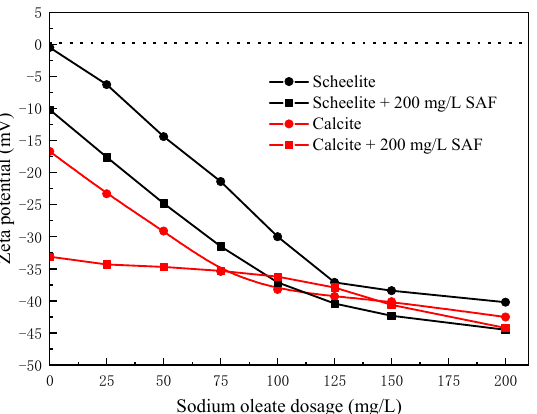
Figure 8. Zeta potential vs. collector dosage in the presence and absence of 200 mg/L SAF at pH